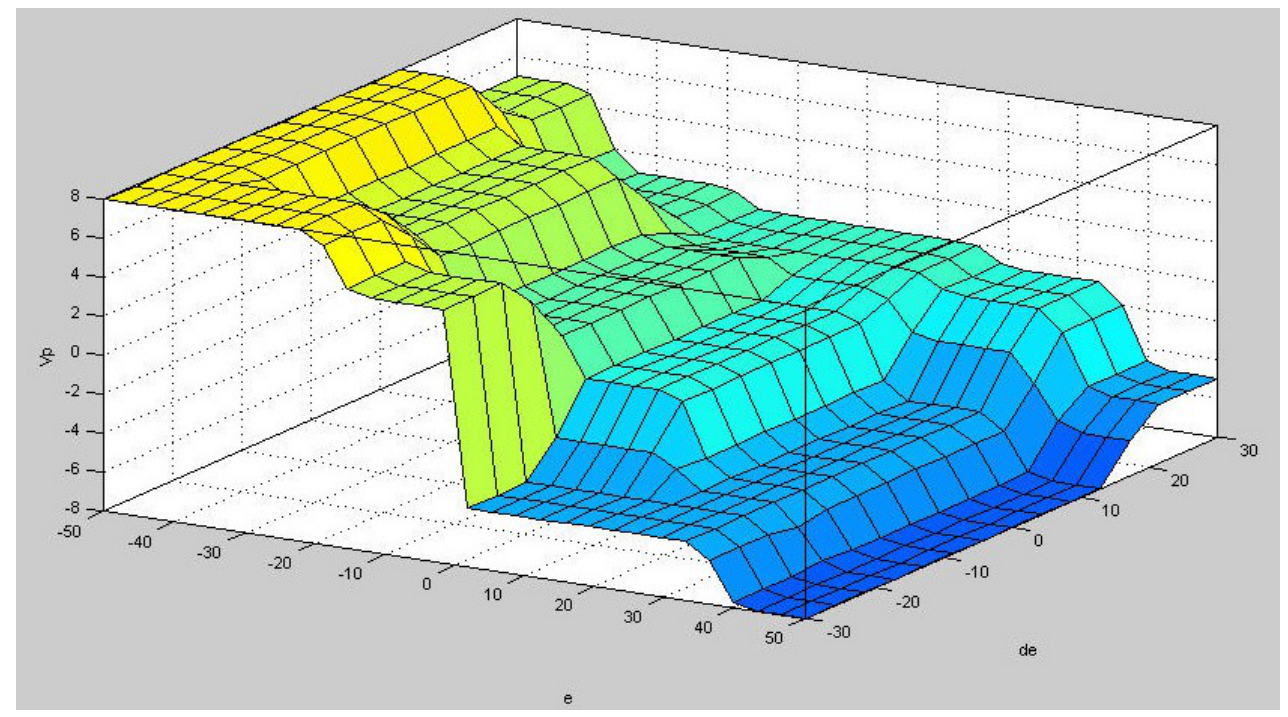
Figure 9. The fuzzy input and output relationship